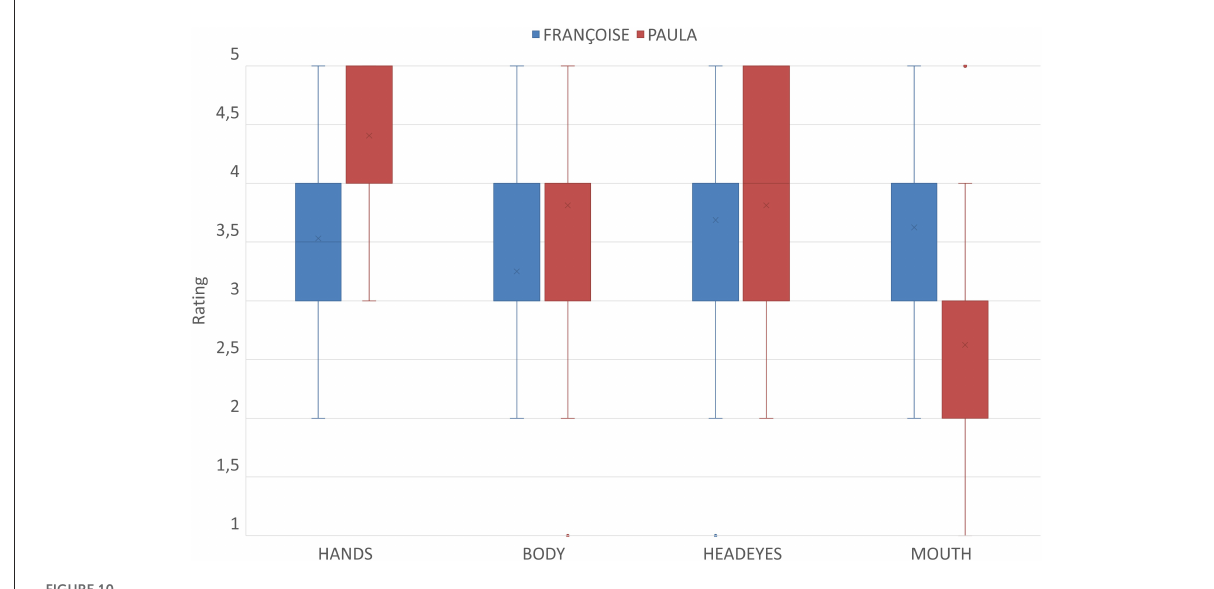
FIGURE10 Central tendency and spread of rankings per movement parameter for both